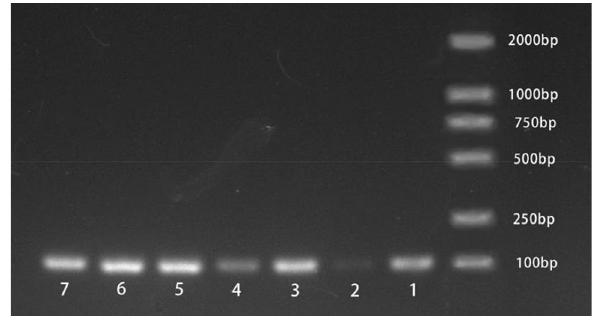
Figure 1. Specificity of Caucasian clover reference gene primer pairs for RT-qPCR amplification. Agarose gel (1.0%) electrophoresis displaying single PCR products with expected sizes for the 12 reference genes (right side, 50 bp DNA ladder). Figures 1–7 represent the RCD1 , PPIL3 , PP2A , NLI1 , NLI2 , EFTu-GTP and RBD reference genes, respectively, and the other reference genes identified via agarose gel electrophoresis are displayed in Fig. S1 of the additional